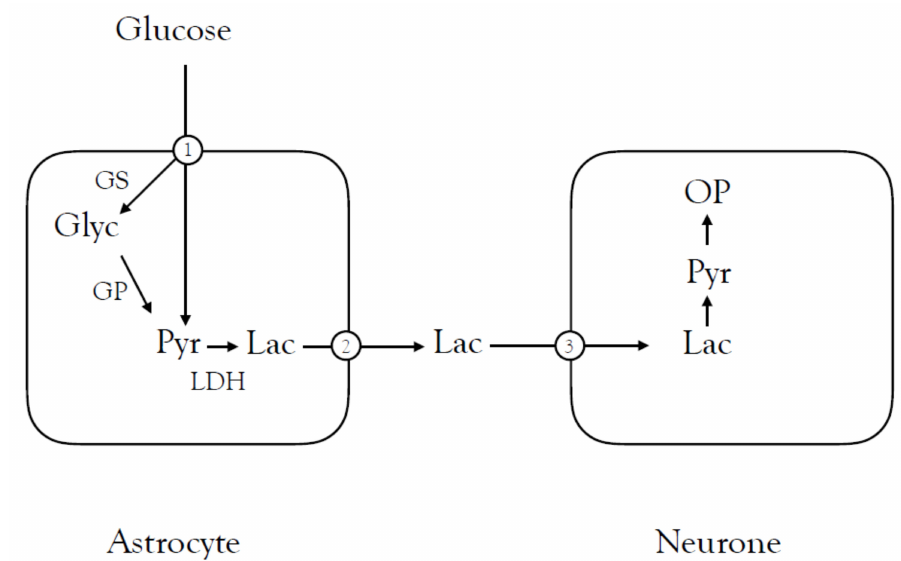
Figure 1. Lactate shuttling between astrocytes and neural elements in the central nervous system (CNS). Glucose enters the astrocyte via the Glut1 transporter (1) and is either glycolytically metabolised to pyruvate or stored as glycogen via the action of glycogen synthase (GS). The glycogen (glyc) is metabolised to pyruvate by glycogen phosphorylase (GP). Pyruvate is converted to lactate by lactate dehydrogenase (LDH) and leaves the astrocyte via the MCT1 transporter (2) and is taken up into the neural element via the MCT2 (3) transporter where it is oxidatively metabolised (OP). Glycogen phosphorylase can be blocked by isofagomine and DAB and the MCT2 transporter can by blocked by cinnemate